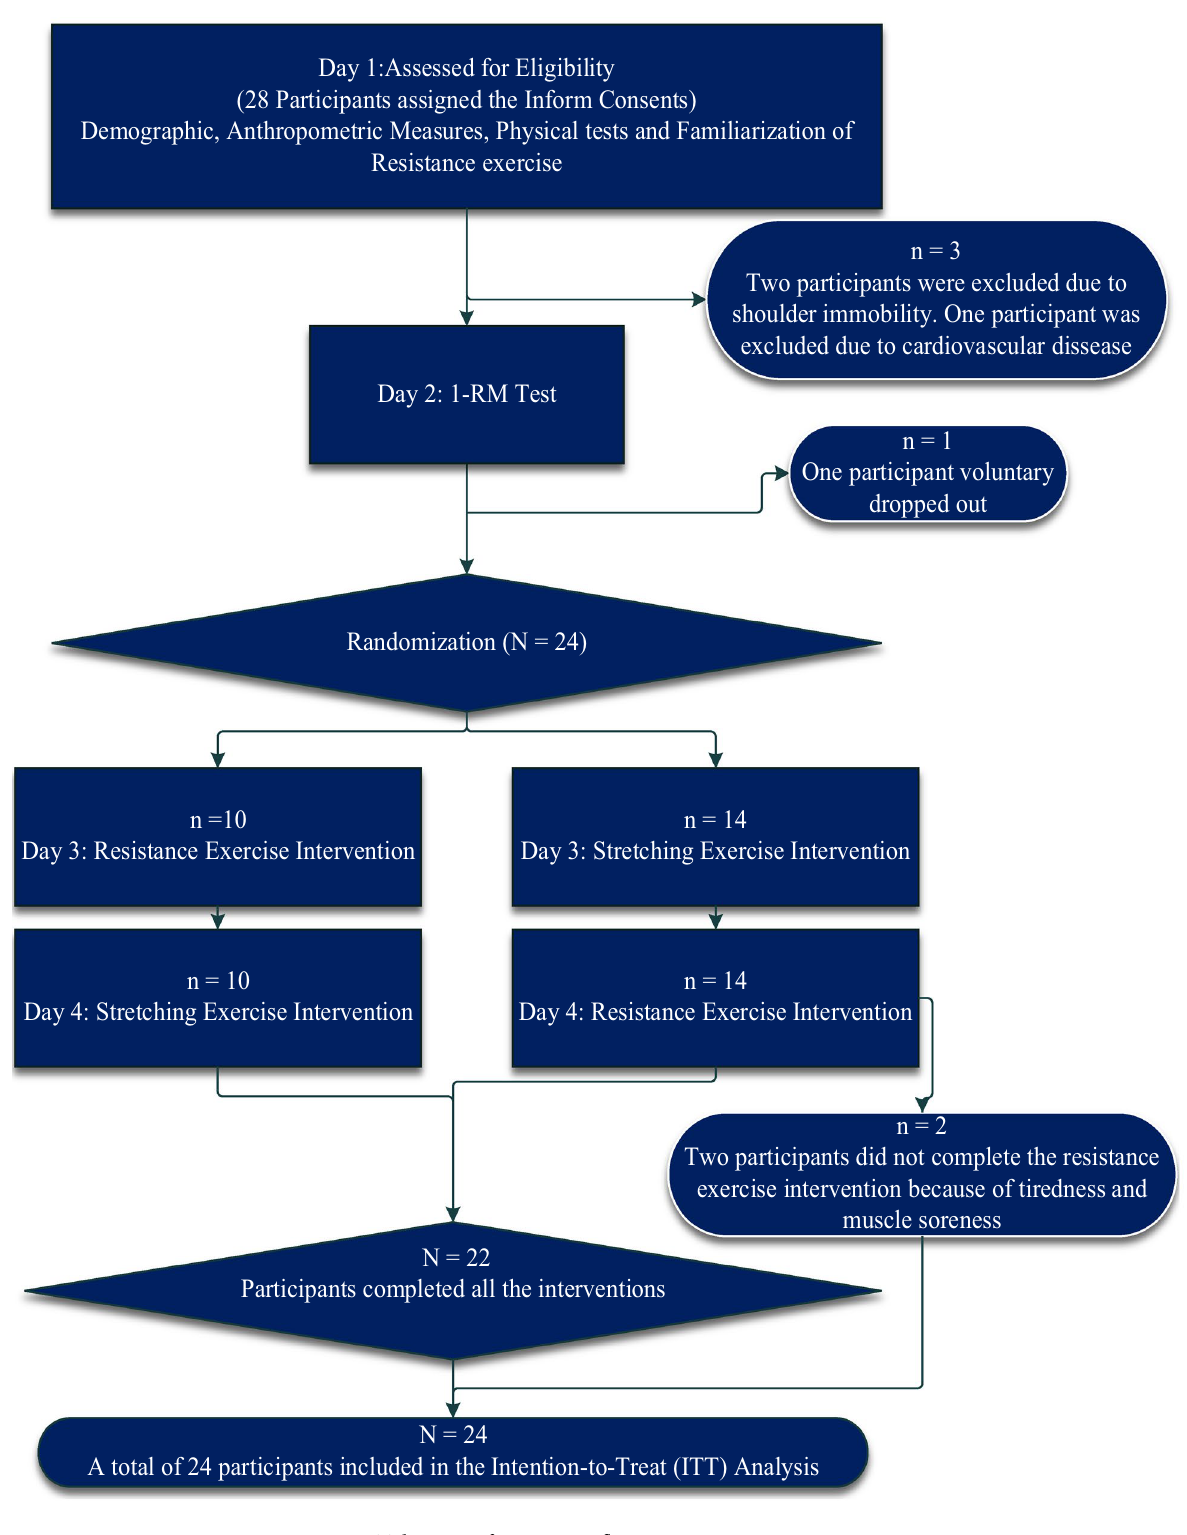
Figure 1. CONSORT diagram of participant